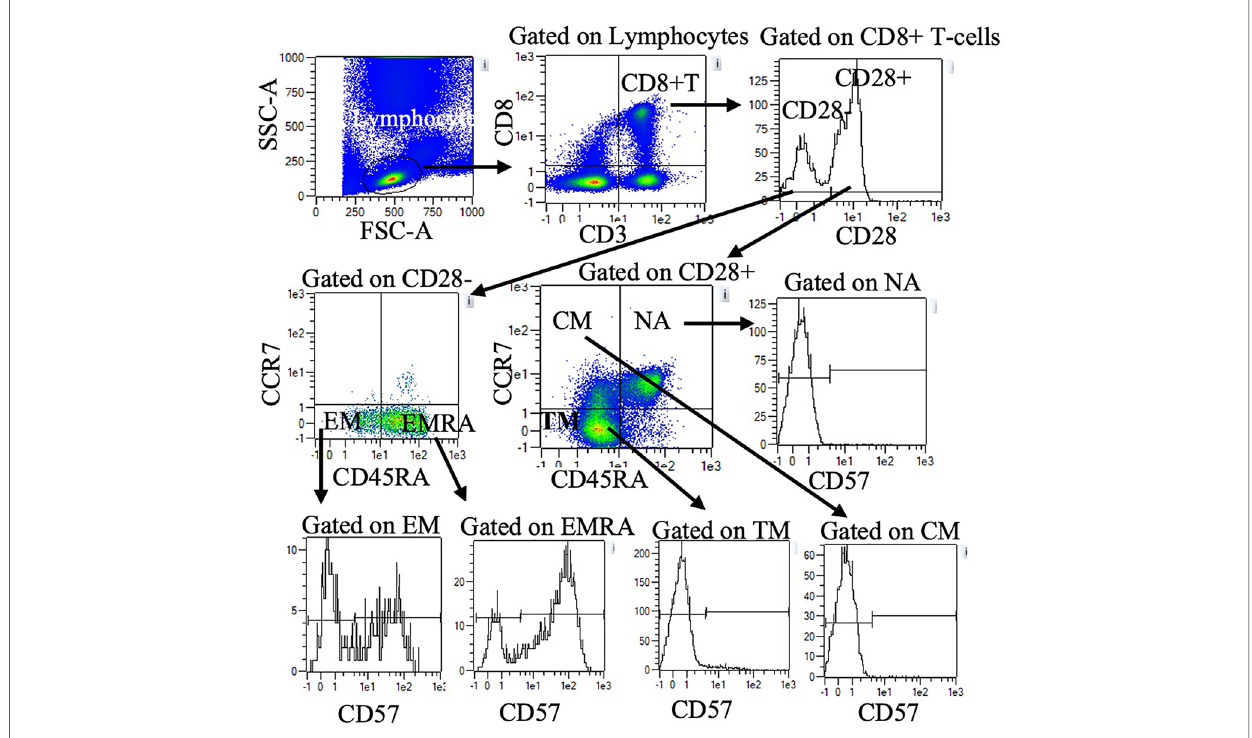
FIGURE 1 Representative fl ow cytometry data to illustrate gating strategy. Plots demonstrate sequential gating of lymphocytes, CD8+ T-cells, and CD28+or CD28- CD8+ T-cells. Within CD28+cells, NA, CM, and TM were identi fi ed by CD45RA and CCR7 expression. Within CD28- cells, EM, and EMRA were identi fi ed by CD45RA and CCR7 expression. CD57+and CD57-cells within NA, CM, TM, EM, and EMRA were further quanti fi ed. A similar gating strategy was applied for CD4+ T-cells (data not shown). NA: naïve, CM: central memory, TM: transitional memory, EM: effector memory, EMRA: RA+effector